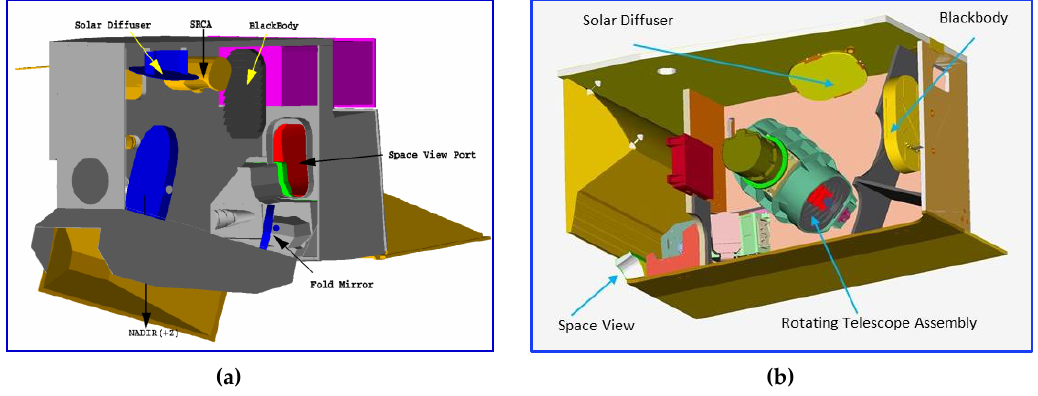
Figure 1. MODIS ( a ) and VIIRS ( b ) instruments and their on-board calibrators (OBC).